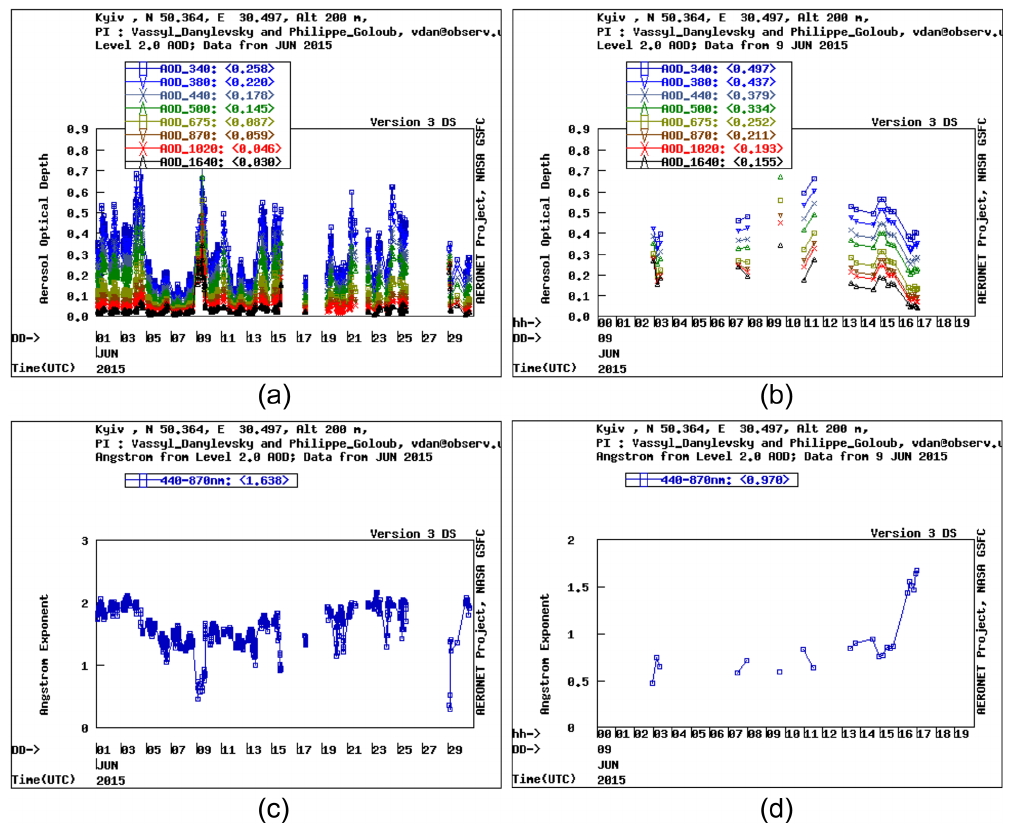
Figure 9. AOD and AE smoke plume values at Kiev on 9 June 2015 and monthly values from June